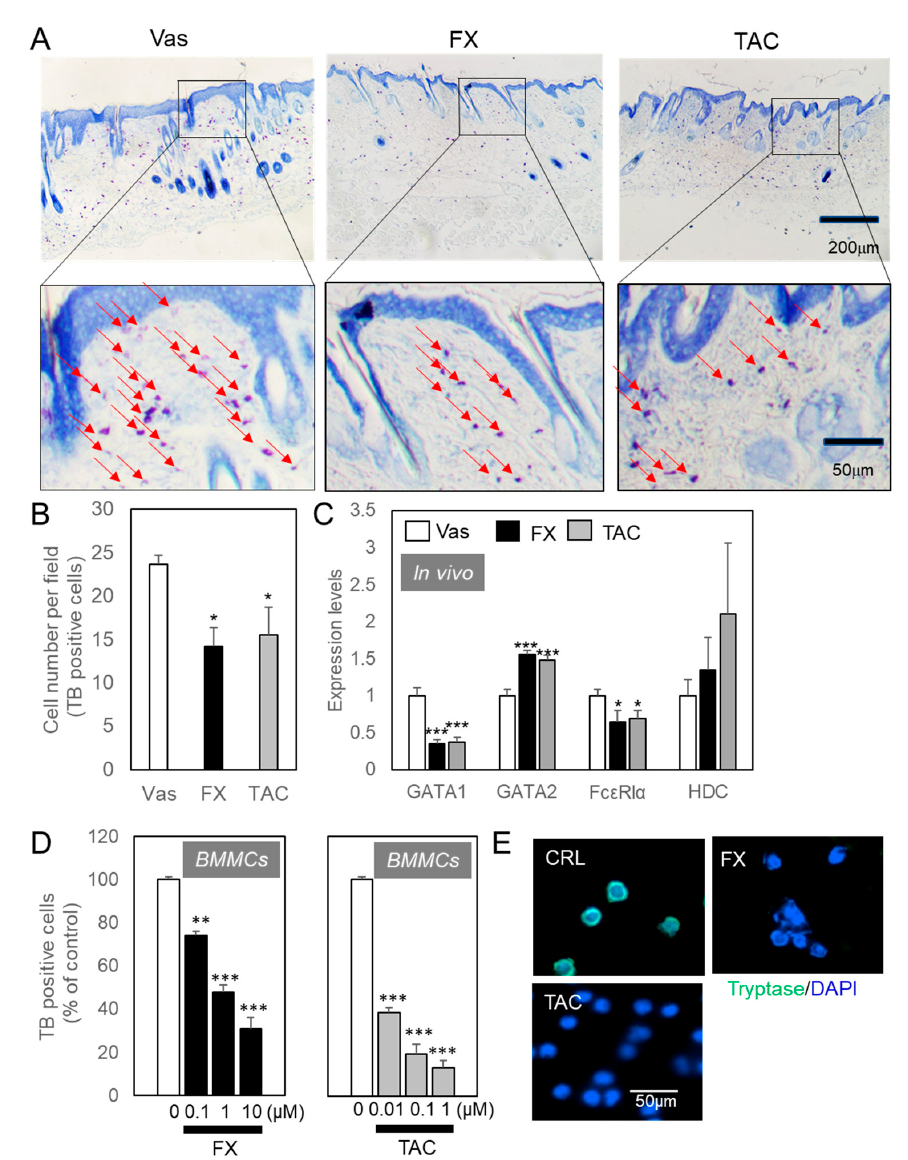
Figure 2. FX or TAC inhibited mast cells formation. After five weeks of treatment, each tissue was excised from the occipital region to around the scapula. Paraffin sections were stained with TB. Sections prepared from all mice were scanned and the number of TB-positive cells was counted. From each section, 30 visual fields were measured. The representative images are shown in ( A ) and a comparison of the number of mast cells per unit field is shown in ( B ). Arrows indicate TB-positive cells. ( C ) FX or TAC inhibited mast cells differentiation in vivo. Skin samples were isolated after five weeks of being treated with respective compounds ( n = 6). mRNA expression levels were analyzed by qRT-PCR. ( D ) FX or TAC inhibited TB-positive bone marrow-derived mast cells (BMMCs) formation in a concentration-dependent manner. After three weeks, cells were fixed and stained. BMMCs were cultured with VEHI-3-CM in the presence or absence of FX or TAC for three weeks. Medium change was performed every other day. Data are shown as percent of dimethyl sulfoxide (DMSO) control ( n = 6). Values are means ± SEM. * p < 0.05, ** p < 0.01, *** p < 0.005 compared with Vas or DMSO control. ( E ) The effect of FX or TAC on tryptase-positive granules formation in BMMCs. Immunocytochemical analysis was performed after three weeks of treatment with 1 μ M FX or 0.1 μ M TAC. Tryptase-positive reaction (green) were not observed in FX- or TAC-treated cells compared to DMSO control. Cells were counter-stained by 4',6-diamidino-2-phenylindole (DAPI) (blue).